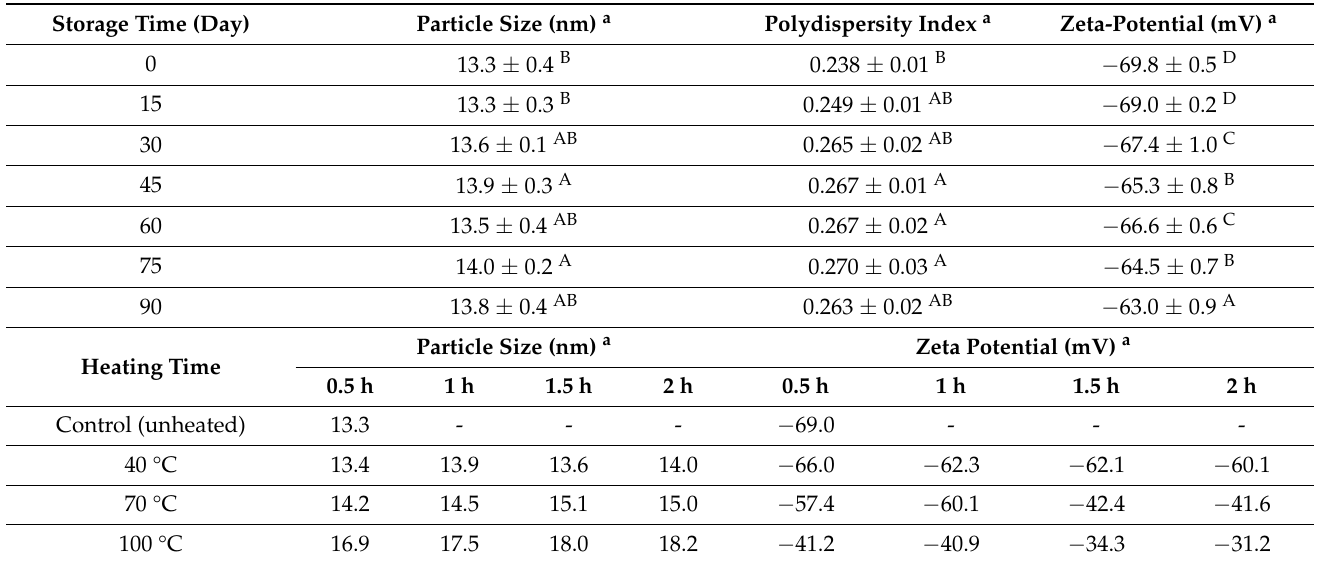
Table 3. Average particle size, polydispersity index and zeta-potential of carotenoid nanoemulsions during storage for 90 days at 25 ◦ C as well as both particle size and zeta potential during heating at different temperatures (40 ◦ C, 70 ◦ C and 100 ◦